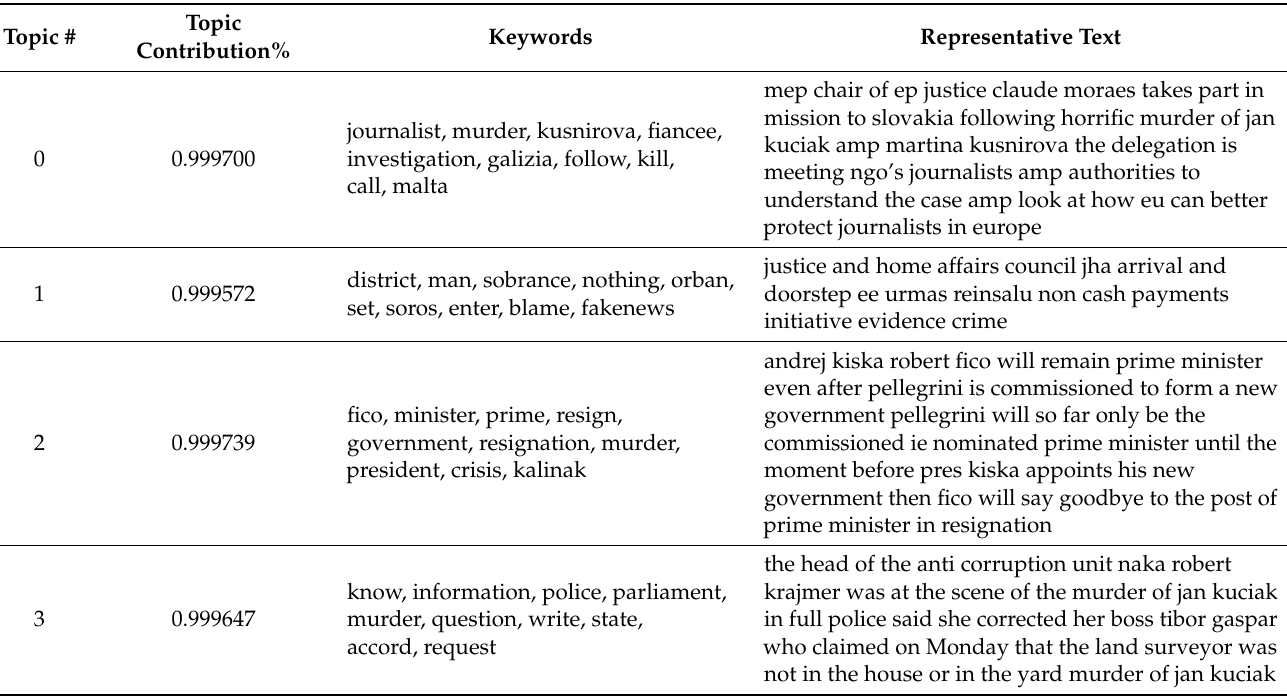
Figure 10. Topic modeling results for tweets in Cluster 5 (RQ2b and RQ3b). Table 3. Topic modeling results of Cluster 5 with representative text for each topic (The text is already pre-processed so it might not always make sense grammatically)—RQ2b and RQ3b.